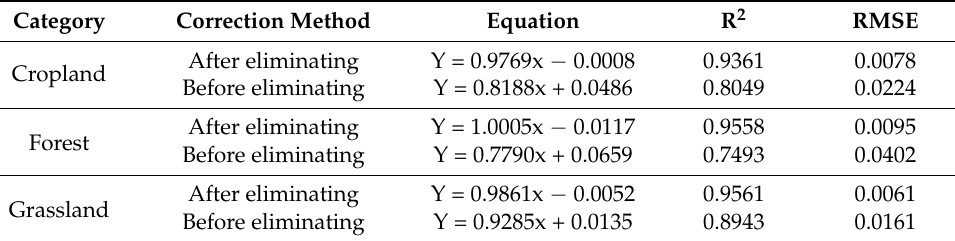
Figure 10. Comparison of apparent reflectance scatter points for correction before and after elimi- nating erroneous pixels. ( a ) Correction before eliminating; ( b ) correction after eliminating. N is the number of image pixels, the black dashed line is the 1:1 line, and the red solid line is the regression line of the scatter plot. Based on statistical comparisons between corrections before and after eliminating erroneous